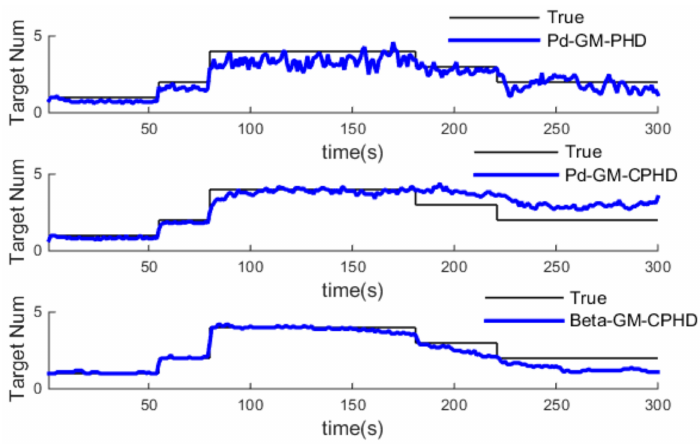
Figure 14. Comparison of target number estimation in clutter intensity κ k = 20.